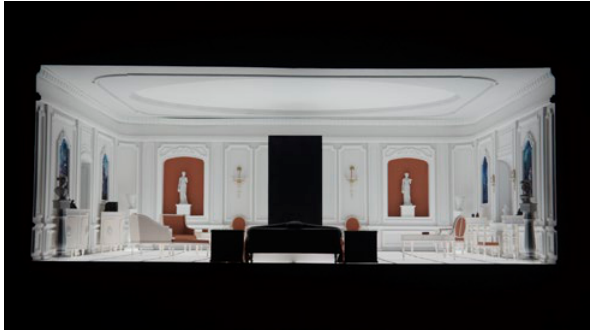
Figure 1. A frame of the movie “2001: A Space Odyssey” directed by Stanley Kubrick. The black monolith was a crystal clear cube in the original script but after considering the technical problems Kubrick decided to use a black cube and then a black